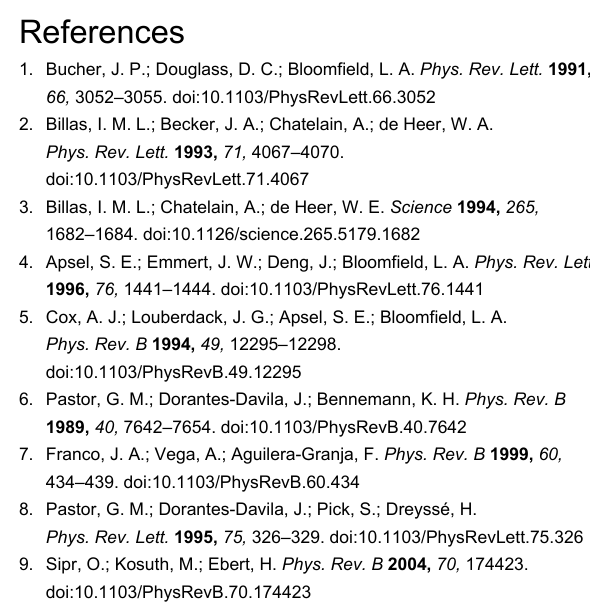
The resonant field ( H r ) was defined as d( Abs. )/d H = 0. At